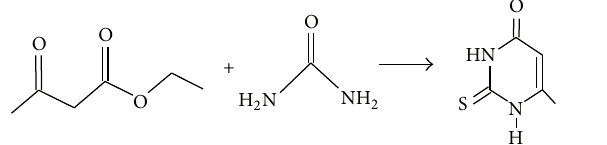
NHO + F 2: Syntheses of 2-(2,6-dihydro-4-methyl-6-oxopyrimidin-2- ylthio)ethanoic acid